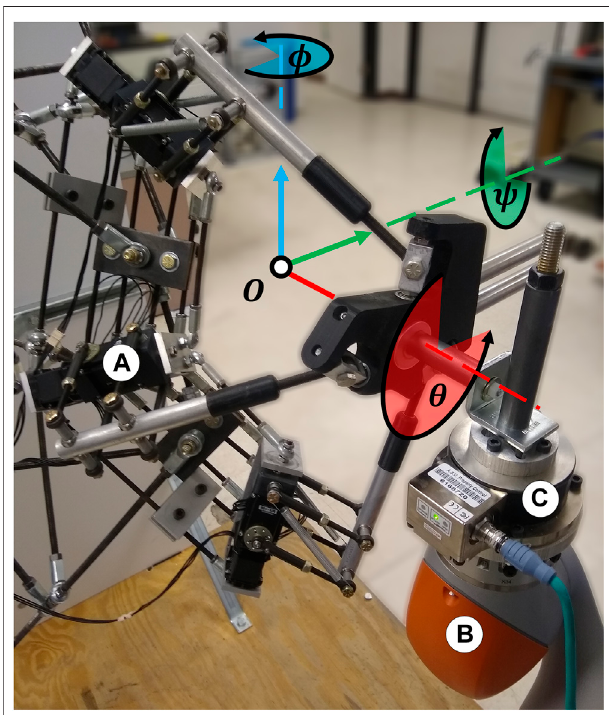
FIGURE 5 | (A) Shown at top is the generalized maximum stiffness con fi guration for the 4B-SPM shoulder exoskeleton substructures along with point clouds of the best solutions found throughout the workspace. Shown at bottom are projections of the generalized maximum stiffness ellipsoid. (B) Shown at top is the generalized minimum stiffness con fi guration for the 4B-SPM substructures along with point clouds of the best solutions found throughout the workspace. Shown at bottom are projections of the generalized minimum stiffness ellipsoid. (C) Shown at top is the generalized maximum desired nonhomogeneous stiffness con fi guration for the 4B-SPM substructures along with point clouds of the best solutions found throughout theworkspace.Shown atbottomareprojectionsofthegeneralizedmaximum nonhomogeneous stiffness ellipsoid. For all three fi gures, the origin of each frame is at the center-of-rotation of the human